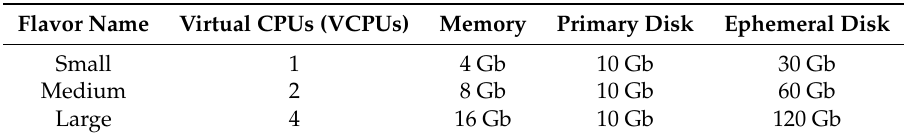
Table 1. Nectar Cloud virtual machine flavours.